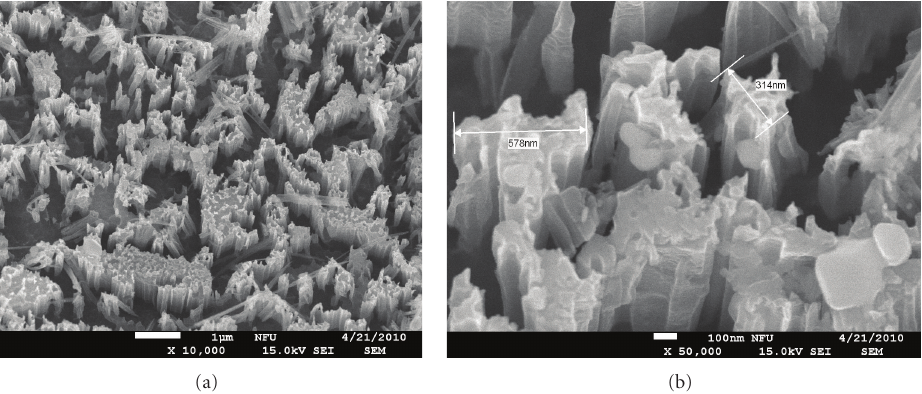
Figure 5: Top morphologies of SNW/p-Si(100) structure, magnified at (a) × 10k, and (b) × 50k. Etching conditions were aqueous AgNO 3 /HF/H 2 O mixed chemical solution in a ratio of 4:34 :162 (volume) at 25 ◦ C for 3min. Cross-sections of SNW arrays had non-regular morphologies and sizes from 300 to 1000